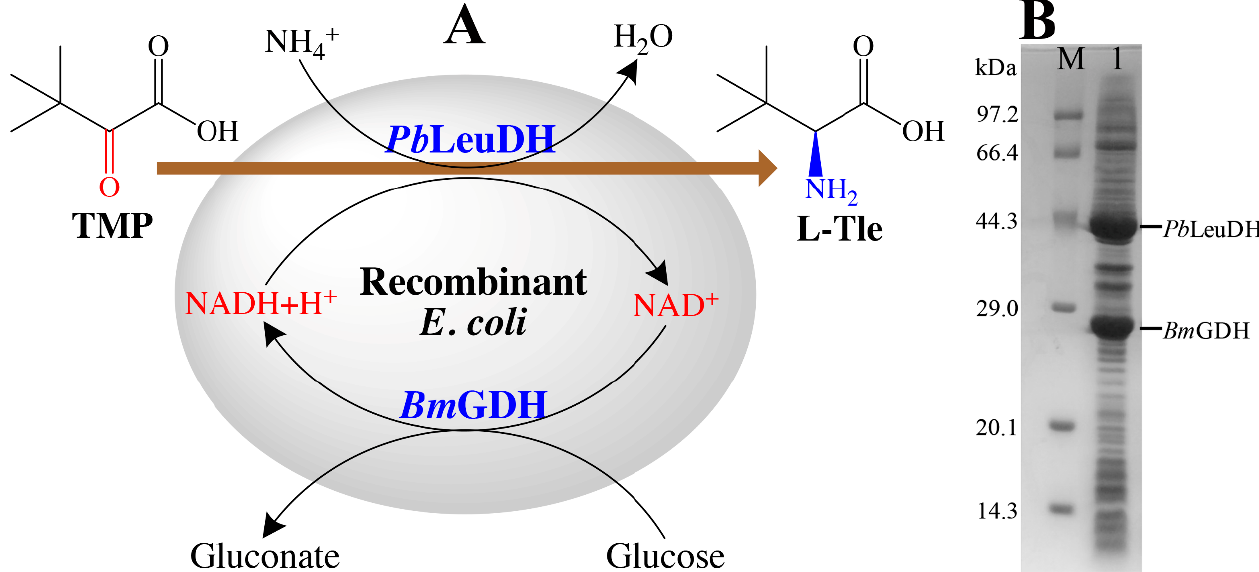
Figure 6. ( A ) Whole-cell biosynthesis of L-Tle from TMP by recombinant E. coli coexpressing Pb LeuDH and Bm GDH; ( B ) SDS-PAGE analysis of E. coli (pET28a- Pbleudh - Bmgdh ). Lane M, marker proteins; Lane 1, E. coli (pET28a- Pbleudh - Bmgdh ).